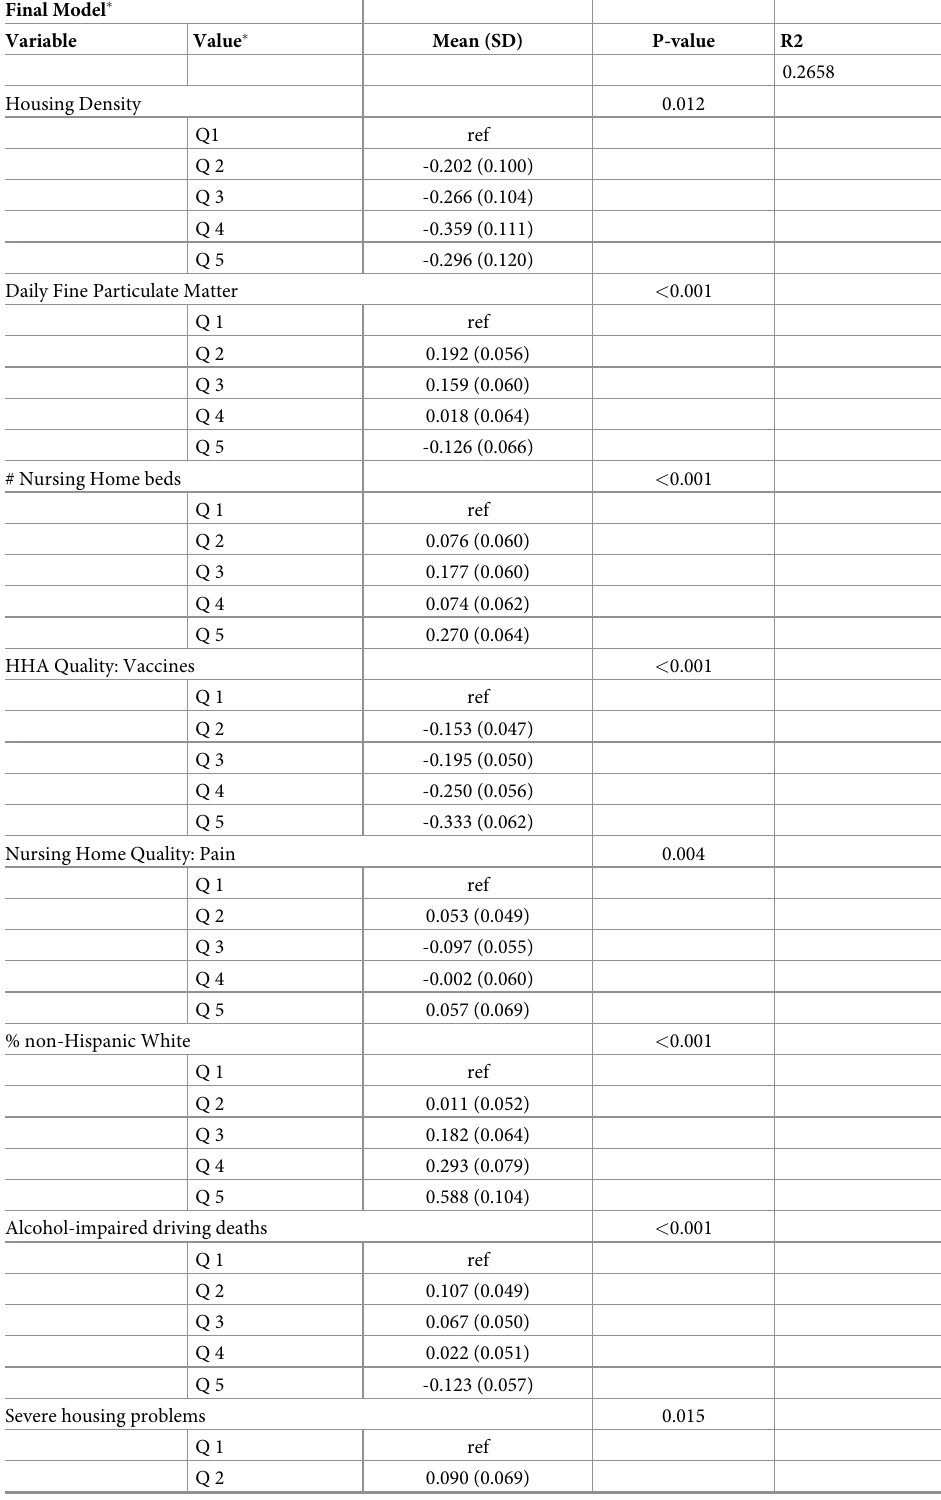
Table 2. Final multivariable